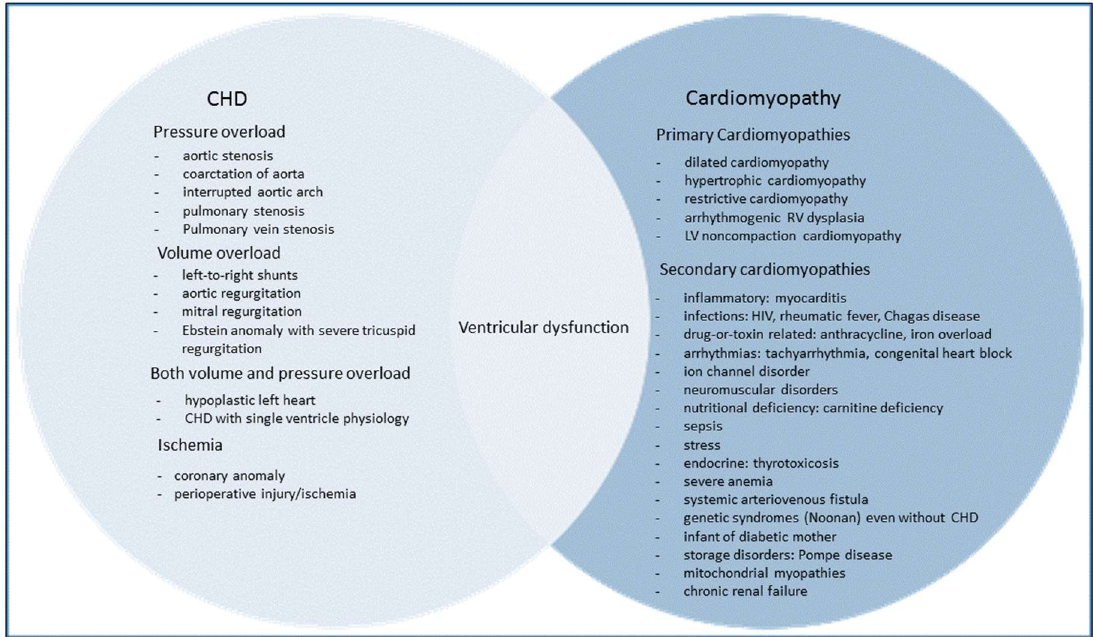
Figure 1. Common causes of heart failure in children—the relationship of ventricular dysfunction to CHD and cardiomyopathy.